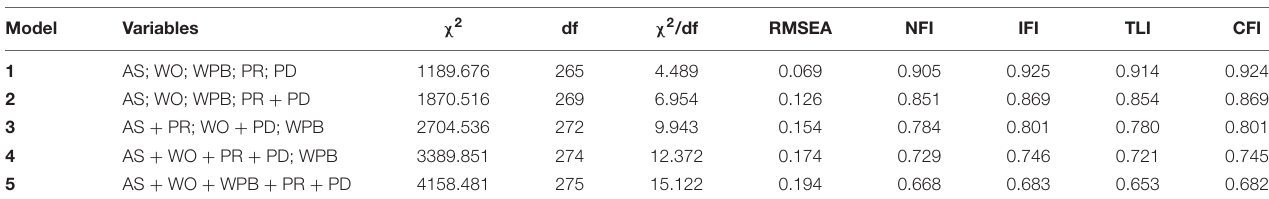
TABLE 1 | Confirmatory factor